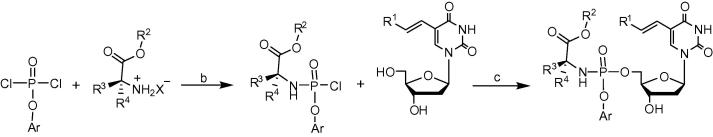
Synthesis of BVdU phosphoramidate analogues; Reagents and conditions: a) Et3N, anhydrous DCM, −78 °C, 2–5 h, b) NMI, anhydrous THF, −78 °C to r.t., 16–18 h.